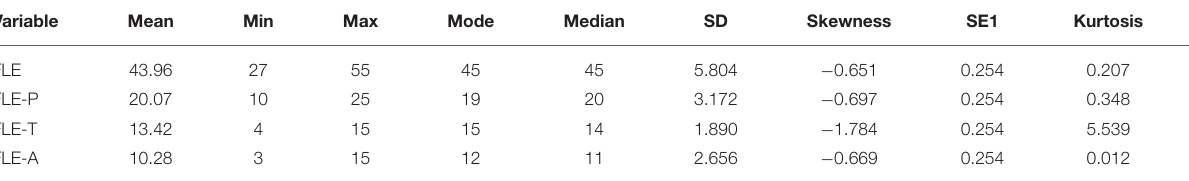
TABLE 2 | Descriptive statistics for FLE and its subscales ( N = 90). Variable